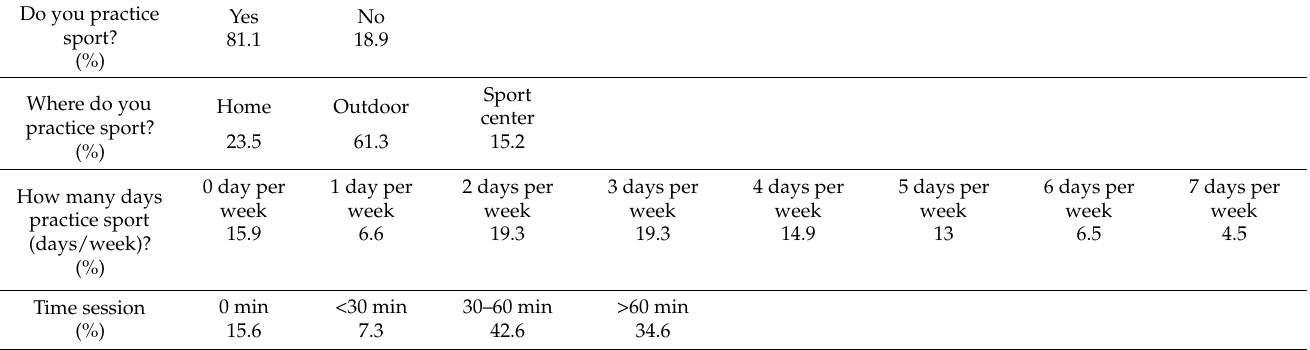
Table 4. Physical activity (values are expressed as percentage).